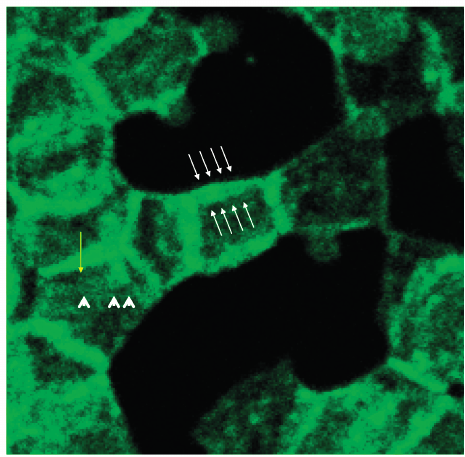
Figure 8. Spectrin stained erythrocytes suspended in a plasma/Iopromide 370 mixture (reprinted from reference [20], Copyright 2013, with permission from IOS Press; primary magnification 1:63; zoom factor 4.5).